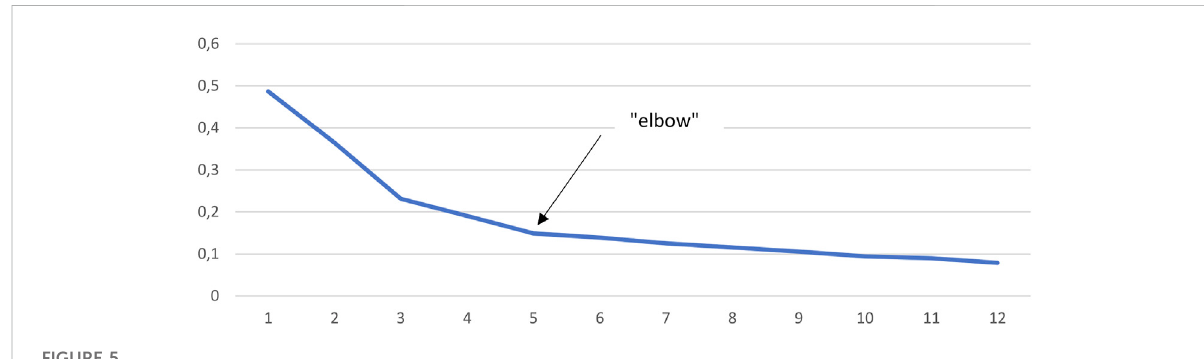
Eigenvalues, Source: own